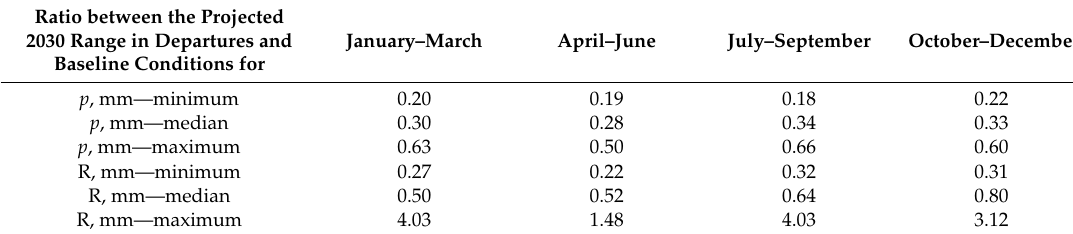
Table 4. Summary statistics for the ratio between projected 2030 ranges (95th − 5th percentile) of departures and baseline (1981–1999) conditions in average monthly precipitation ( p ) and runo ff (R) for each season, for the 374 National Park Service